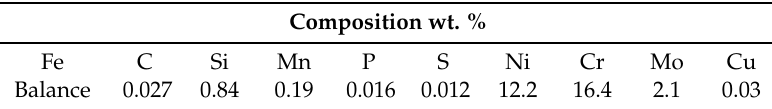
Table 1. Chemical composition of water atomized SS316L powders supplied by Epson Atmic Corp., Aomori Prefecture, Japan (wt. %).